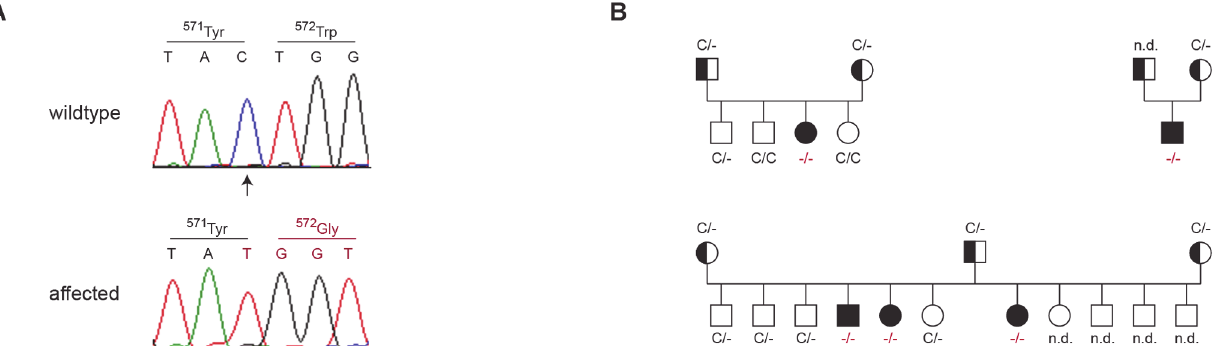
Fig 2. Experimental confirmation of the DWLM associated cytosine deletion by Sanger sequencing. (A) Electropherograms of the VLDLR : c . 1713delC variant. A fragment harboring exon 12 and flanking sequences of the VLDLR gene was PCR-amplified and sequenced with the Sanger method. The figure shows representative traces from a normal and a DWLM affected Eurasier dog. The position of the deleted cytosine is indicated by an arrow. (B) Perfect cosegregation of the VLDLR : c . 1713delC variant with the DWLM phenotype in four litters of Eurasier dogs. Filled symbols represent DWLM affected dogs. Obligate carriers are indicated by half-filled symbols. The transmission of the two different alleles is within the expected equal ratio and the offspring ’ s genotype distribution corresponds to Mendelian rules.